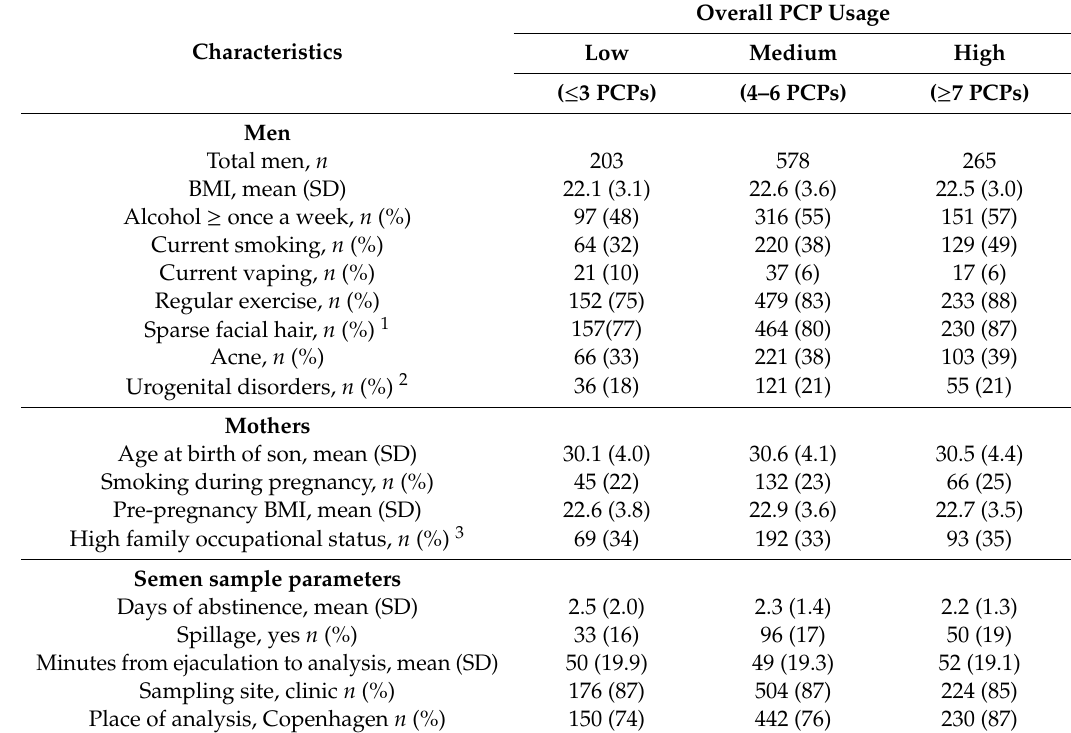
Table 2. Characteristics of the FEPOS cohort stratified by aggregated PCP